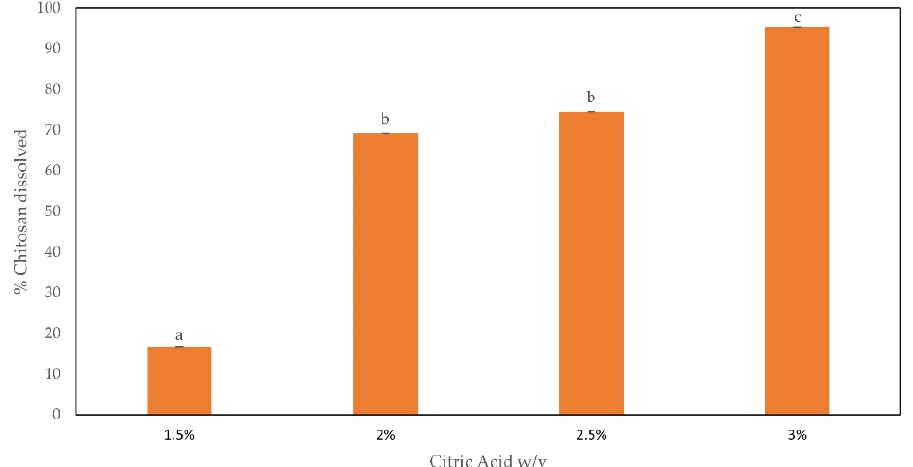
Figure 1. CH solubility, expressed in percentage, when dissolved in CA. Different small letters (a–c) indicate significant differences among the values reported in each bar ( p < 0.05).